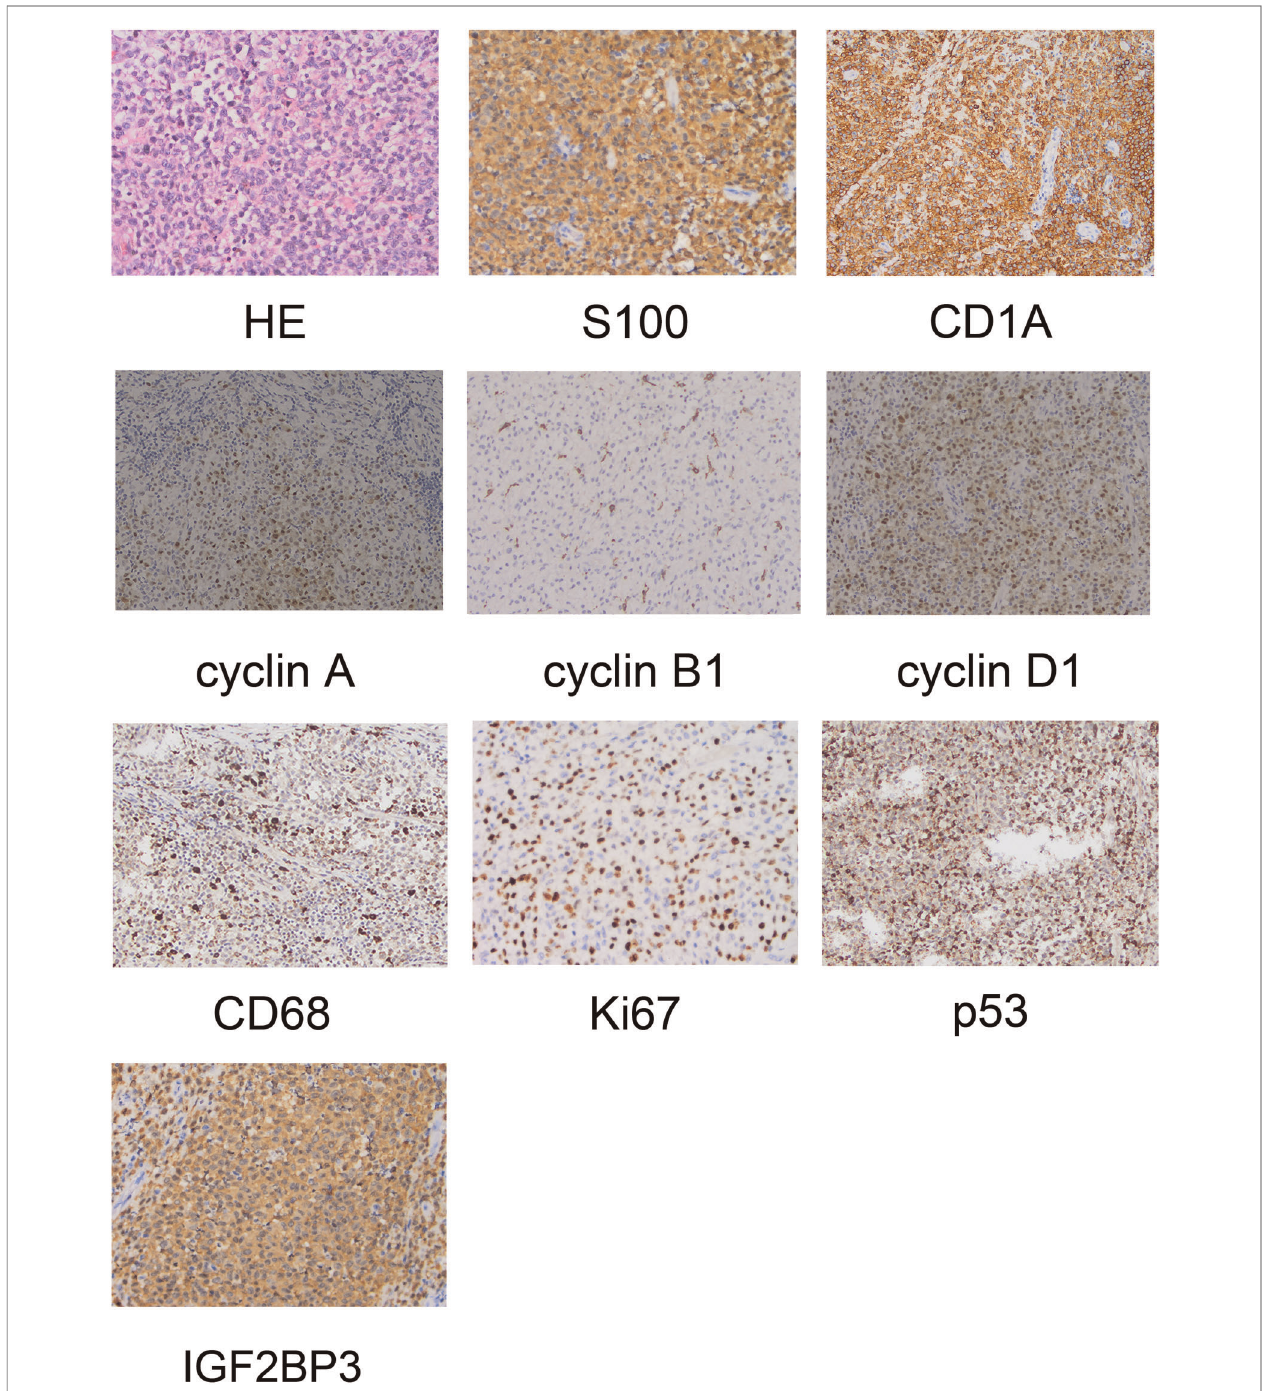
FIGURE 2 | Pathological examination revealing the morphology of Langerhans cell sarcoma and positive immunohistochemical